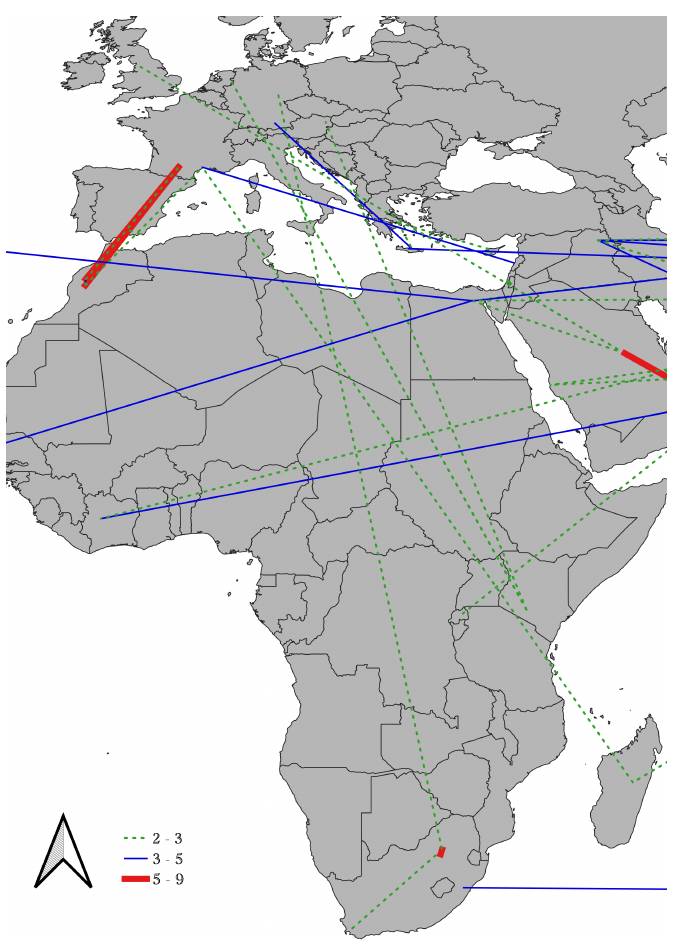
Figure 18. Connections of affiliations of articles published in Remote Sensing with an affiliation in Africa.